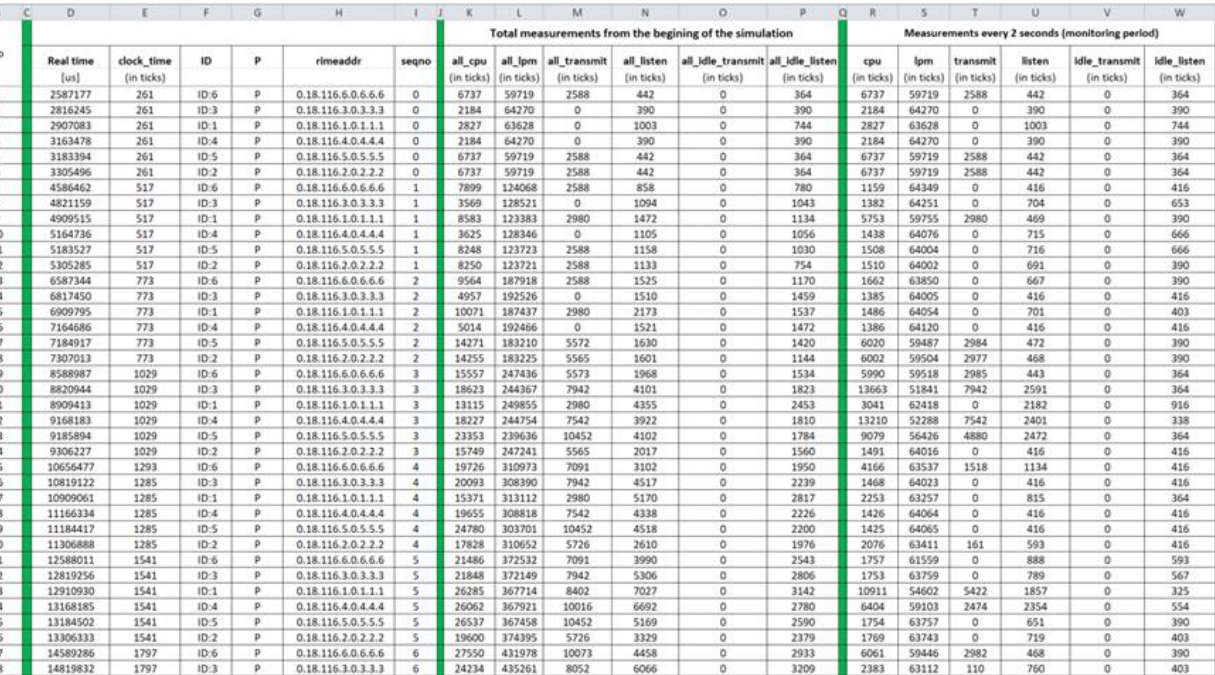
Figure 11. Benign “pwrtrace.csv”— 1 to 38 records.